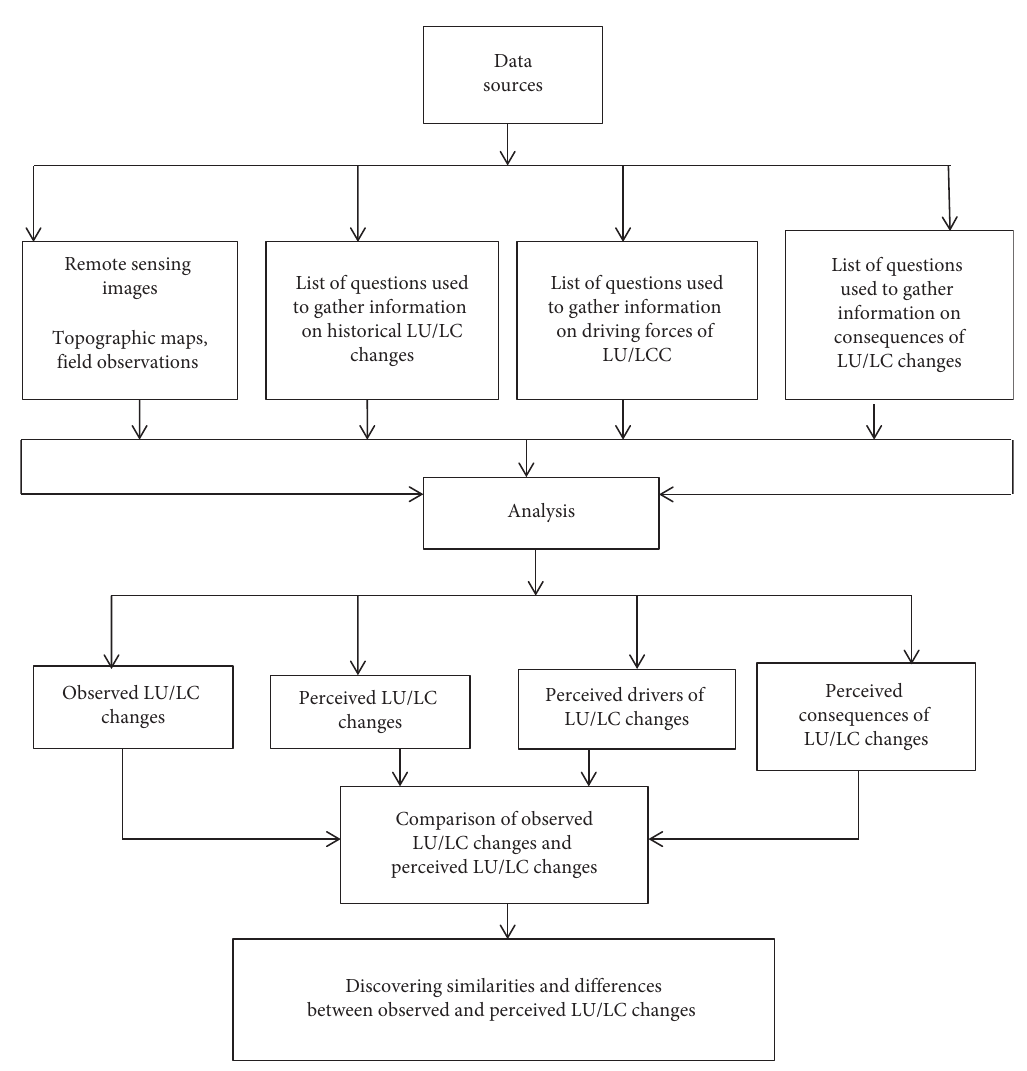
Figure 3: Methodology of comparison between observed and perceived LU/LC changes. Table 3: Accuracy assessment (in percent) of the 1973, 1995, and 2017 LU/LC